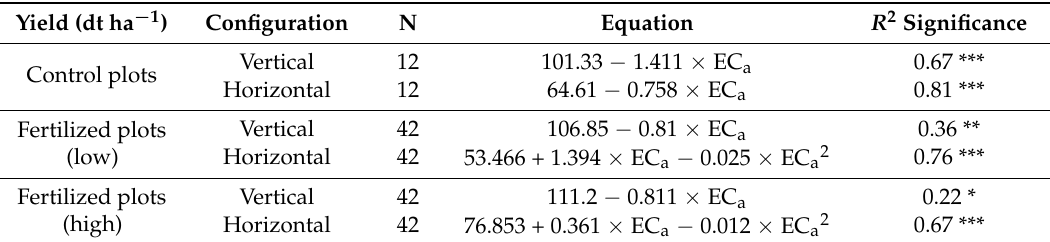
Table 7. Regressions between EC a and multi-annual mean of yield (wheat) of the long-term experiment Dürnast 020 in dependence of fertilization level (see Figure 1).